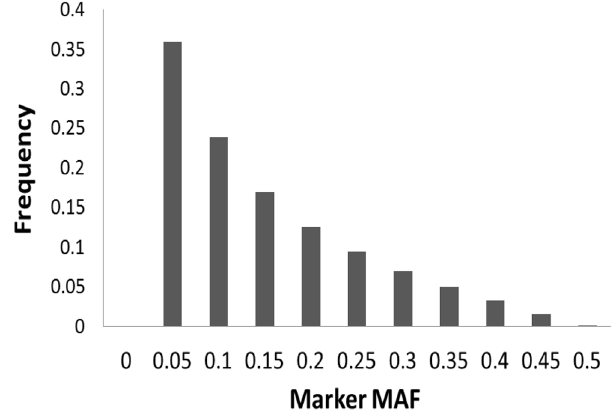
Figure 1. Frequency of markers in different MAF Classes.